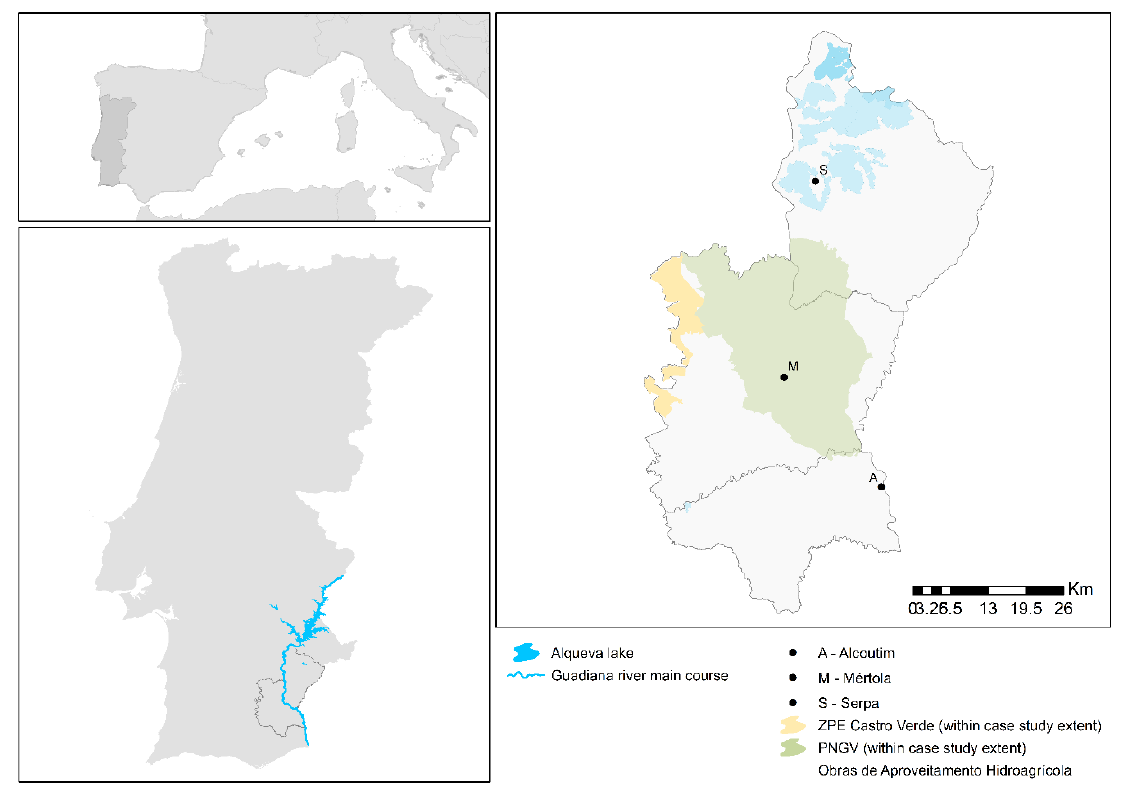
Figure 1. Location of the case Figure 1. Loc ation of the case study. Table 1 . Summary information on the characteristics of the three municipalities of the case study.